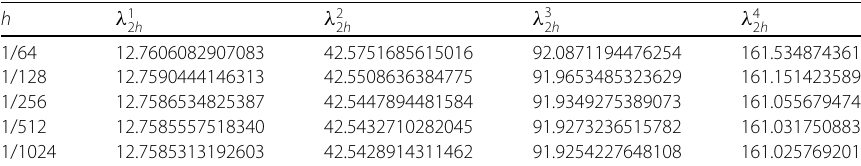
Table 9 a > 0, the four eigenvalues with l = 2 and h